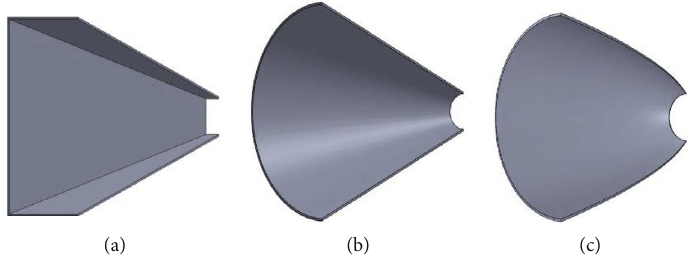
Figure 12: Cross-sections of the test inlet shapes: (a) pyramidal inlet, (b) conical inlet, and (c) parabolic inlet